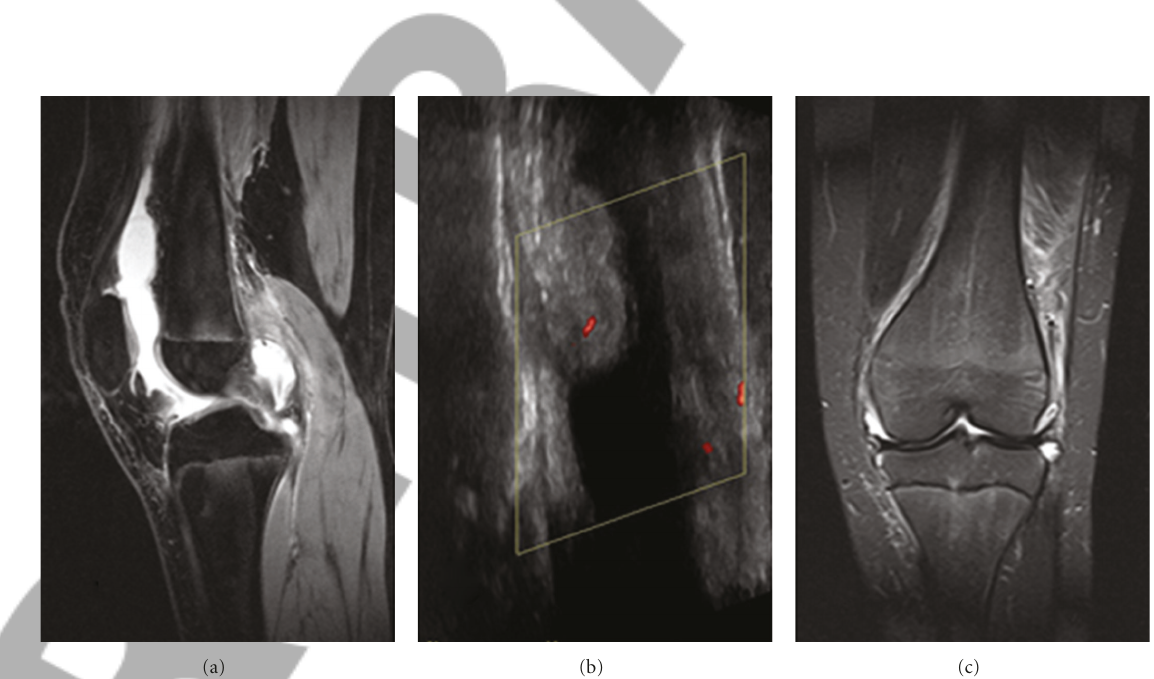
Figure 2: MRI and US of the left knee at the disease presentation. T2-weighted sagittal image (a) and US (b) demonstrated synovial thickening with increased vascularity (b) and joint e ff usion. The signal intensity of the distal femur and proximal tibia is normal (a),